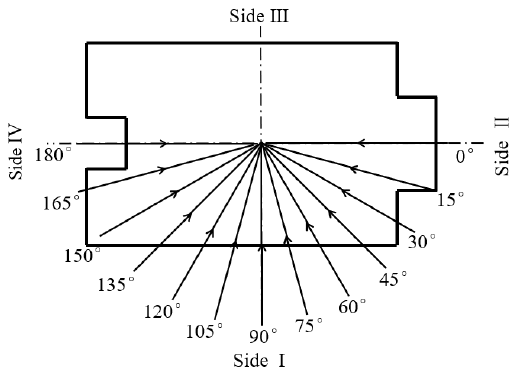
Figure 2. Wind fields in the wind tunnel : ( a ) Schematic diagram of the wind tunnel ( b ) uniform inflow condition in the wind tunnel without rough elements or wedges; ( c ) atmospheric boundary layer flow condition in the wind tunnel with rough elements and wedges; ( d ) wind speed profile and the turbulence intensity profile in the wind tunnel; ( e ) turbulent wind power spectrum of the incoming flow in the wind tunnel.